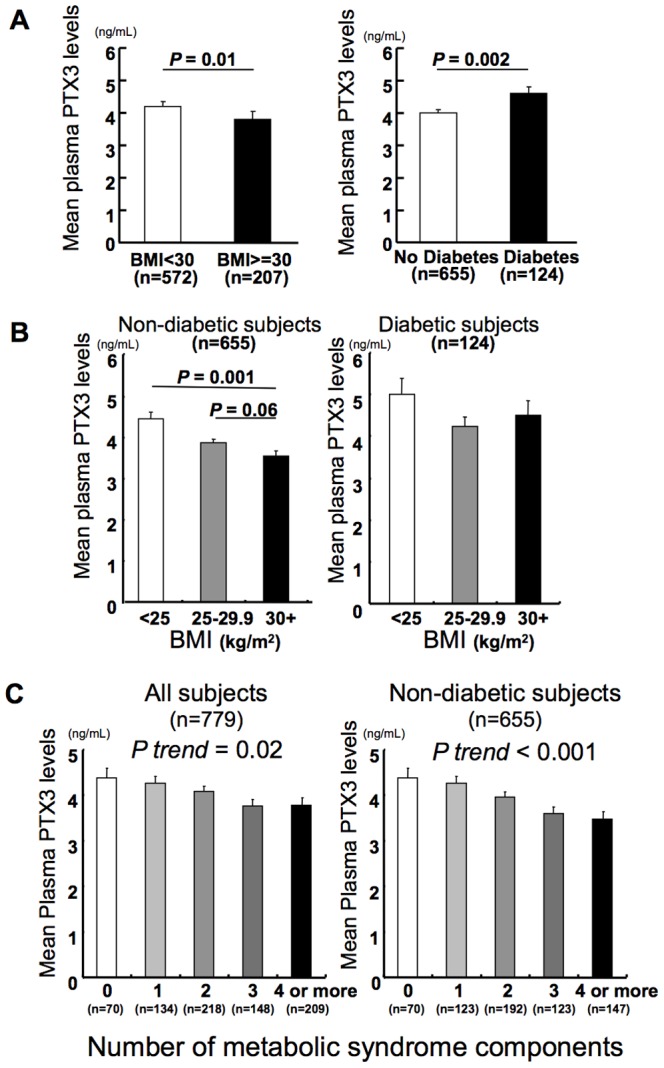
PTX3 associates negatively with obesity and metabolic syndrome in non-diabetic subject.PTX3 associates negatively with obesity but positively with diabetes mellitus (A). Mean plasma PTX3 levels among 779 individuals, comparing non-obese (BMI <30) and obese individuals (BMI ≥30) (left), or non-diabetic and diabetic control individuals (right). Mean values were estimated from linear regression models, adjusted for age, sex, smoking status, triglycerides, HDL cholesterol, and hypertension. Models for diabetes also adjusted for BMI. PTX3 negatively associates with obesity among non-diabetic individuals (B). Mean values of plasma PTX3 levels by BMI category in non-diabetic (left) and diabetic individuals (right) estimated from linear regression models. Mean values adjusted for age, sex, smoking status, triglycerides, HDL cholesterol, and hypertension. PTX3 associates negatively with the number of metabolic syndrome components (C). Mean values of plasma PTX3 levels according to presence of 0, 1, 2, 3, and 4 or more components of metabolic syndrome in all individuals (left) and non-diabetic individuals (right). Mean values estimated from linear regression models, adjusted for age, sex, and smoking status.